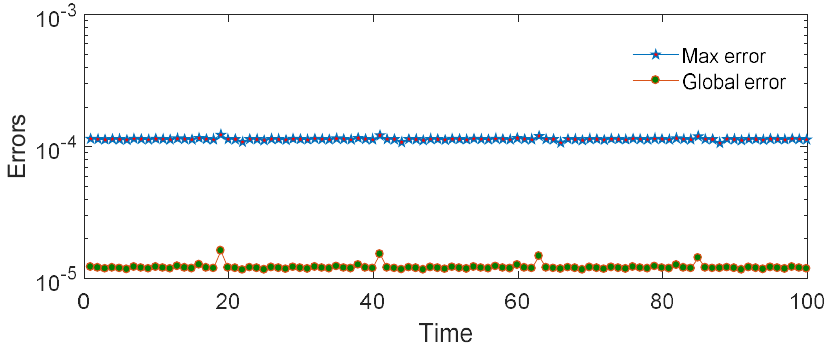
Figure 10. Two types of error curves of hydraulic head H from t = 0 to t = 100.